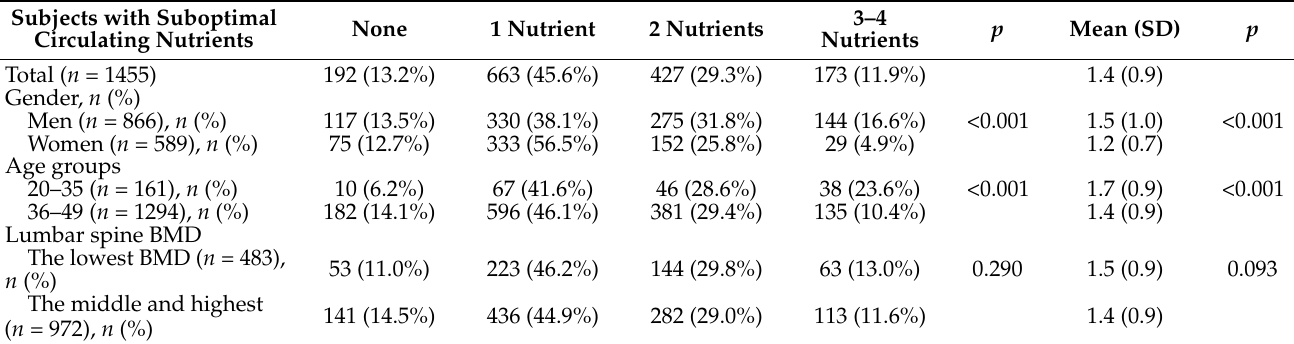
Table 2. Distribution of suboptimal circulating nutrients for the four selected nutrients in the study population.